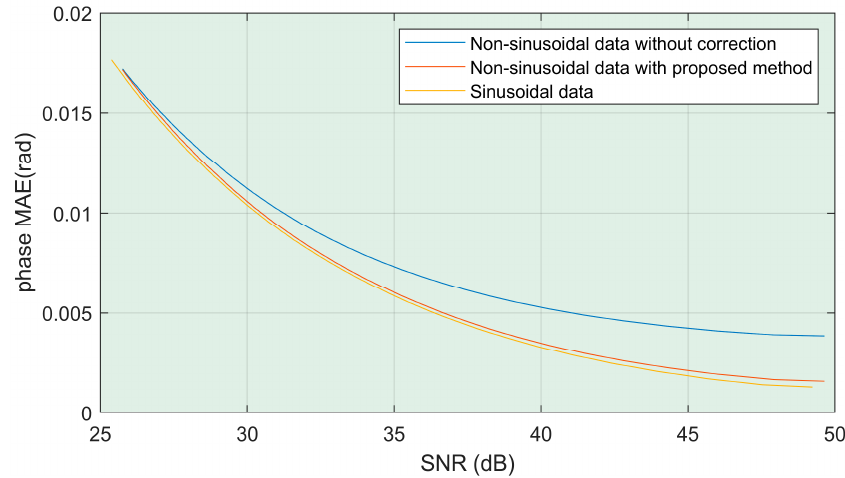
Figure 8. Phase accuracy under different SNRs.